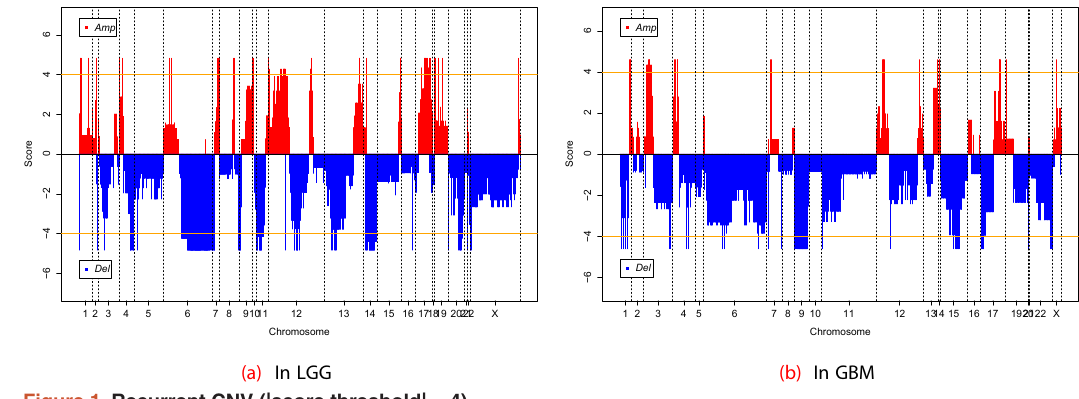
Figure 1. Recurrent CNV (|score threshold| = 4).